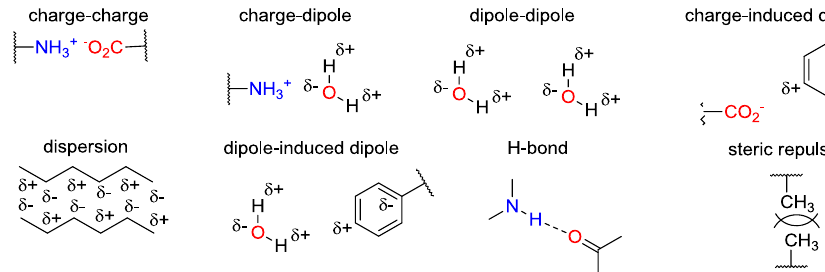
Figure 9. Possible non-covalent interactions, see Ref. [43].